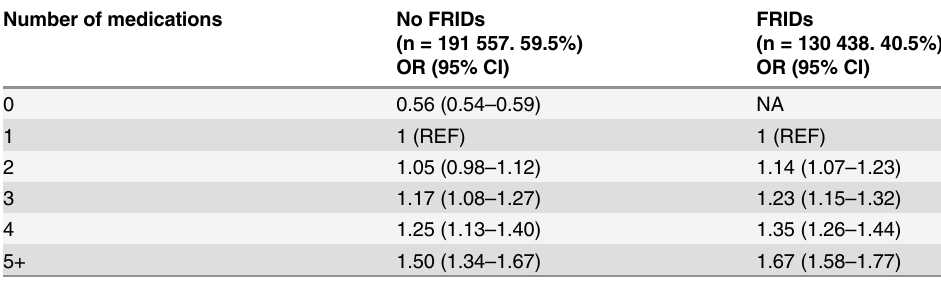
Table 3. Adjusted 1 Odds Ratio for Injurious Falls by Number of Medications. Stratified by Dispensed FRIDs Last 30 Days. Number of